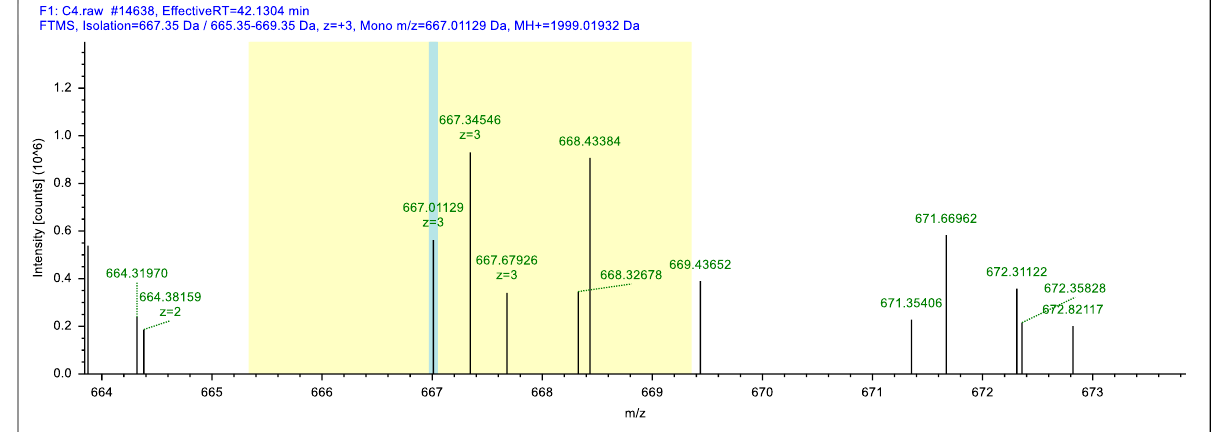
Figure 5. The EQKHIQKEDVPSERYL fragment in papain hydrolysate analyzed via MS. 3.6. Determination of Degree of Hydrolysis, Bitterness Value (BV), and Molecular Weight Distribution of Hydrolysate The BV of each protease hydrolysate was significant difference using the sensory evaluation method (Figure 6). The pepsin hydrolysate of acid protease and Alcalase was graded with the highest BV of 10.0 and 8.5, respectively. Among the neutral proteases, the BVs of Alcalase, Protamex, and Neutrase hydrolysate were between 7.0–8.0. Notably, the papain hydrolysate was graded with a lower BV of 4.0–5.0, while the protease M hydrolysate had the lowest BV of 1.0–2.0.